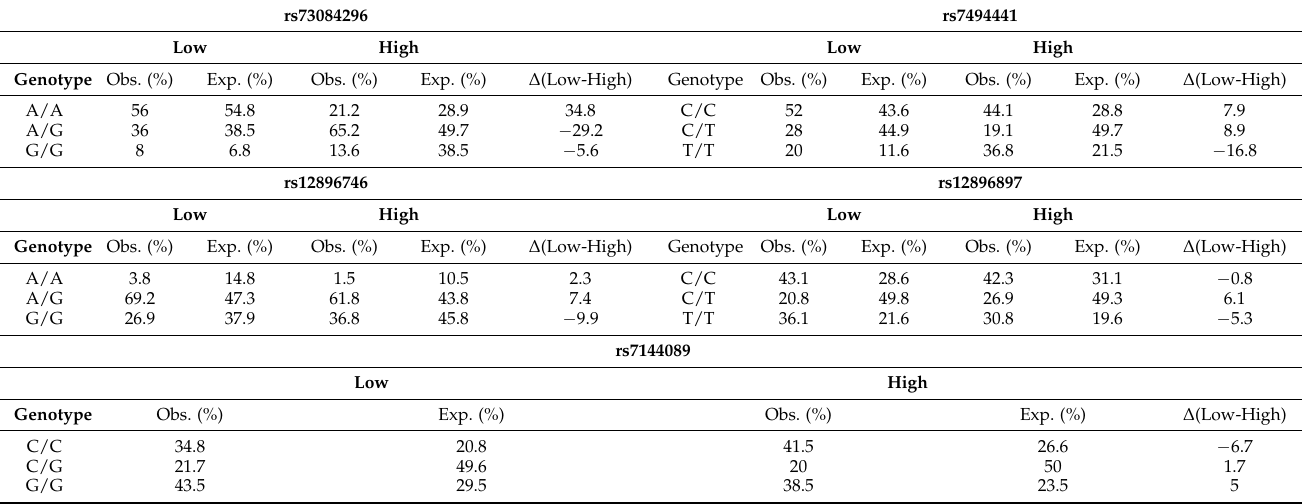
Table 3. Distribution of observed (Obs.) and corresponding expected (Exp.) genotypes under Hardy–Weinberg equilibrium in both cohorts of seronegative individuals with low and high antibody levels in response to the BNT162b2 vaccine. Only the SNPs with populations in Hardy–Weinberg disequilibrium are reported. The difference between low vs. highly responsive subjects for the observed genotype in each SNP is indicated as “ ∆